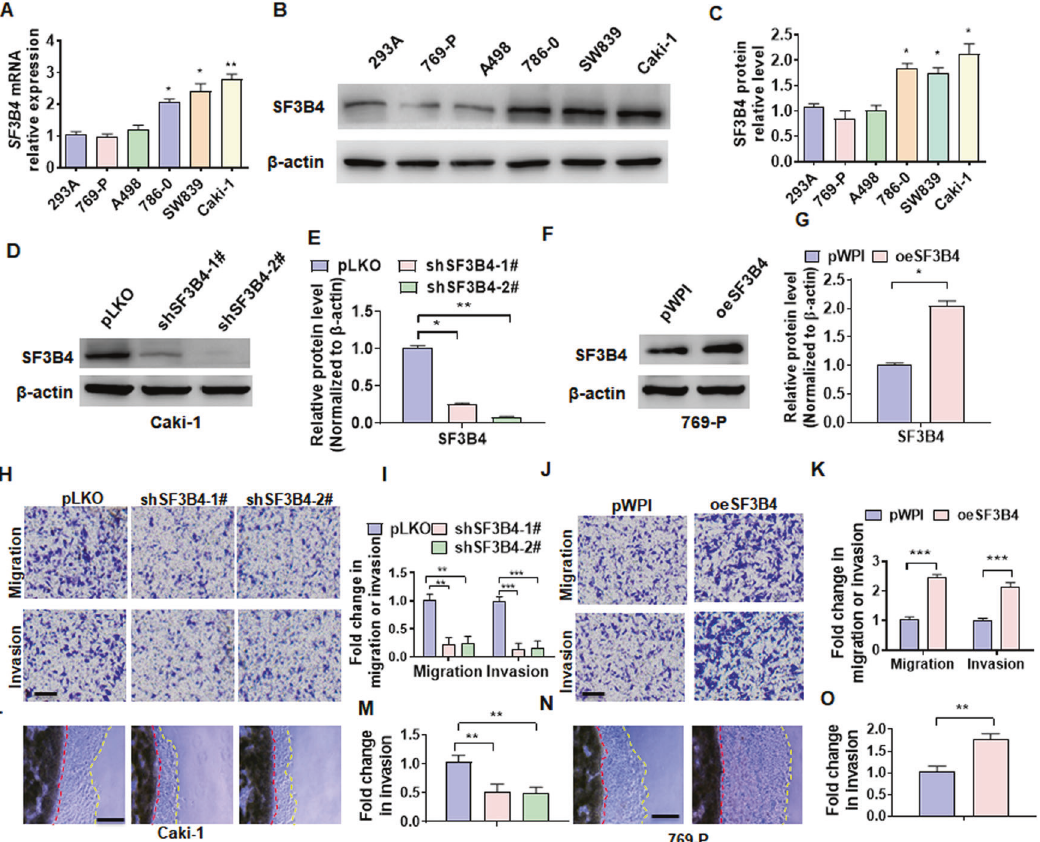
Fig. 2 The upregulation of SF3B4 promotes migration and invasion of ccRCC cells. A , B RT-qPCR and Western blotting detected the SF3B4 expression in different cell lines of ccRCC. C Quantitative analysis of B . D , E Caki-1 cells were transfected with pLKO, shSF3B4-1#, or shSF3B4-2#, and then western blot analysis examined the SF3B4 and MMP1 expression. F , G 769-P cells were transfected with pWPI or pWPI-SF3B4 (oeSF3B4) and then SF3B4 and MMP1 were examined by western blot. H Caki-1 cells were treated as in D and transwell assay and detected the migration and invasion of cells. Scale bar = 50 μ m. I Quantitative analysis of H . J 769-P cells was treated as in F and then the migration and invasion of cells were detected by transwell assay. K Quantitative analysis of J . L Caki-1 cells were treated as in D and a 3D Matrigel